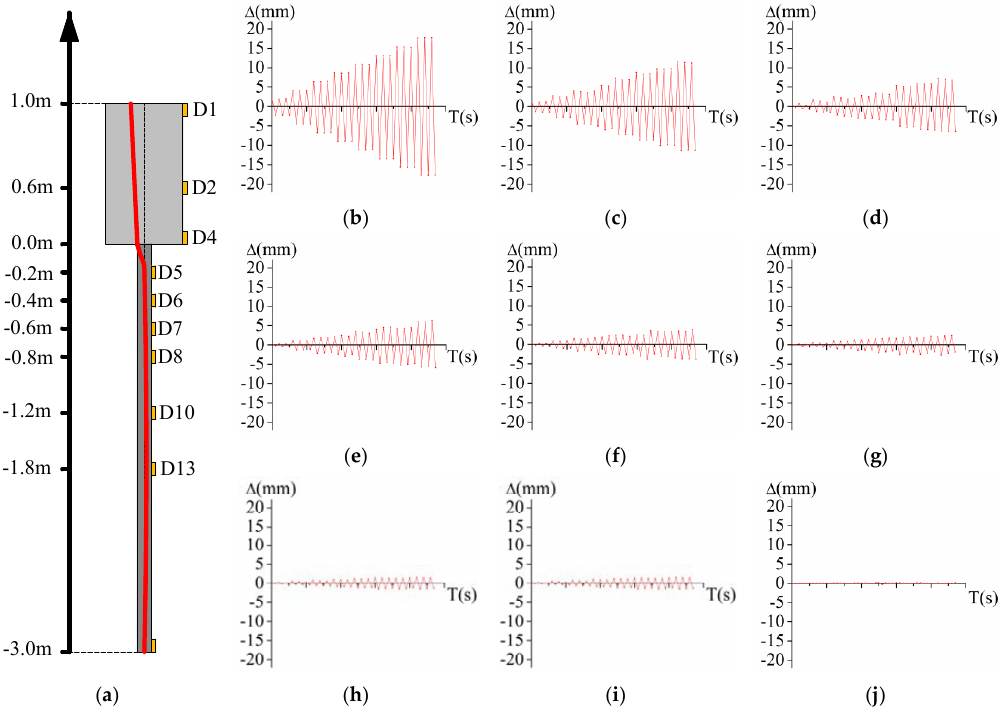
Figure 20. Time ‐ history curves deducting accumulative deformation. ( a ) The locations of nine measurement points and the distribution (red line) of the specimen deducting accumulative deformation. ( b ) D1. ( c ) D2. ( d ) D4. ( e ) D5. ( f ) D6. ( g ) D7. ( h ) D8. ( i ) D10. ( j ) D13.